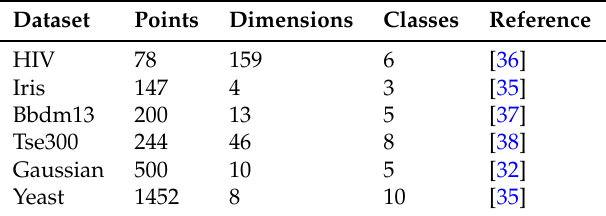
Table 1. Experiment